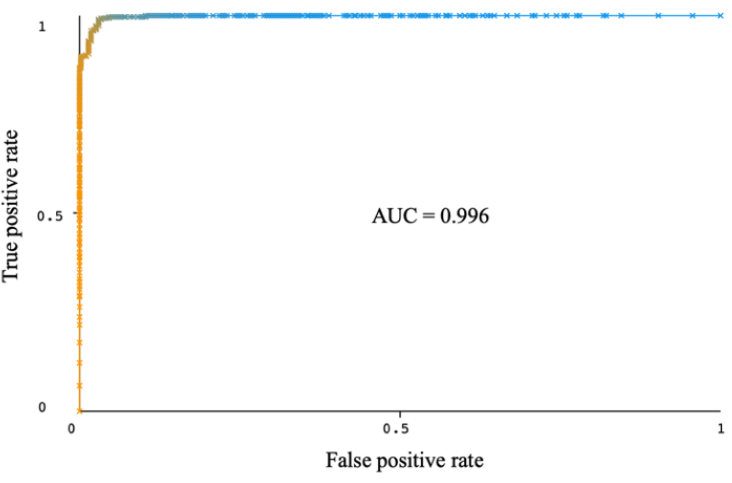
Figure 10. Roc plot of the rotation forest ensemble after optimization. From Figure 10, the area under the ROC curve of the Rotation Forest ensemble on optimal components is 0.996, the same as that obtained with this ensemble on the complete set of principal components as in Figure 6a. An AUC value close to 1 indicates that the model can achieve a high true positive rate, the proportion of instances that are correctly identified as positive for the disease, while still maintaining a low false-positive rate, the proportion of individuals who are incorrectly classified as positive for the disease. The bar chart of the machine learning model’s cost (incorrectly classified instances) utilizing optimal components, based on Tables 7 and 15, without and with hyperparameter optimization, is shown in Figure